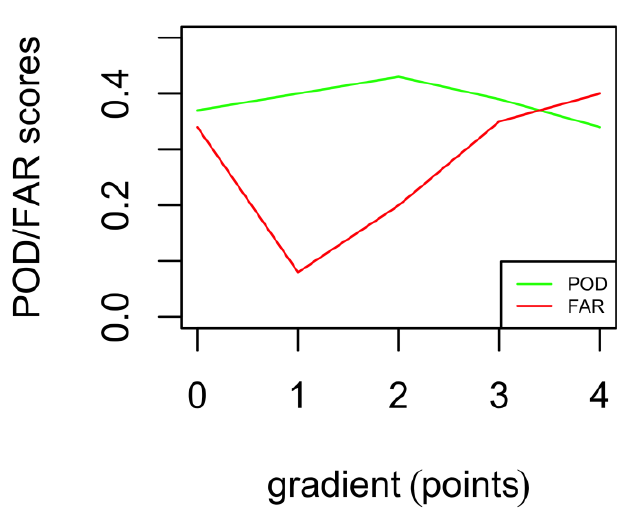
Figure 8. POD and FAR scores as a function of the number of points used for the calculation of the gradients of the meteorological fields.